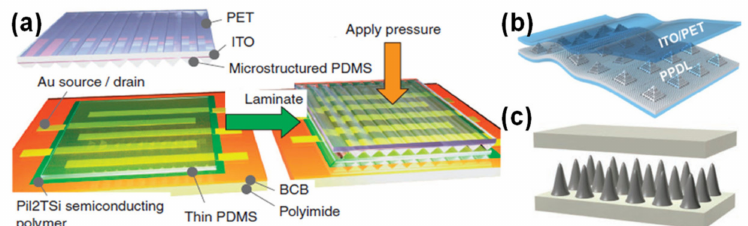
Figure 4. Capacitive e-skin sensors, developed by ( a ) Zhenan Bao and co-workers in 2013 [30] (Copyright © 2020, Springer Nature), ( b ) Steve Park and co-workers in 2019 (reprinted with permission from [85]. Copyright 2019 American Chemical Society, Washington, WA, USA), and ( c ) Run-Wei Li and co-workers in 2020 [86] (Copyright © 2020 WILEY-VCH Verlag GmbH & Co. KGaA, Weinheim,